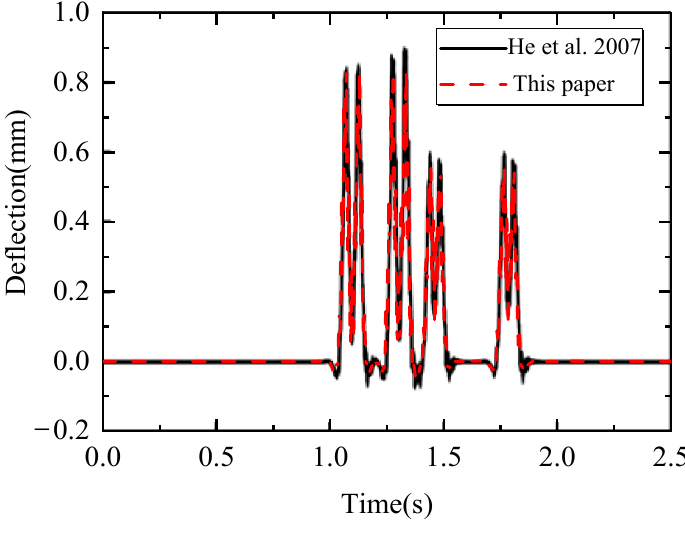
Figure 3. Model validation [33].